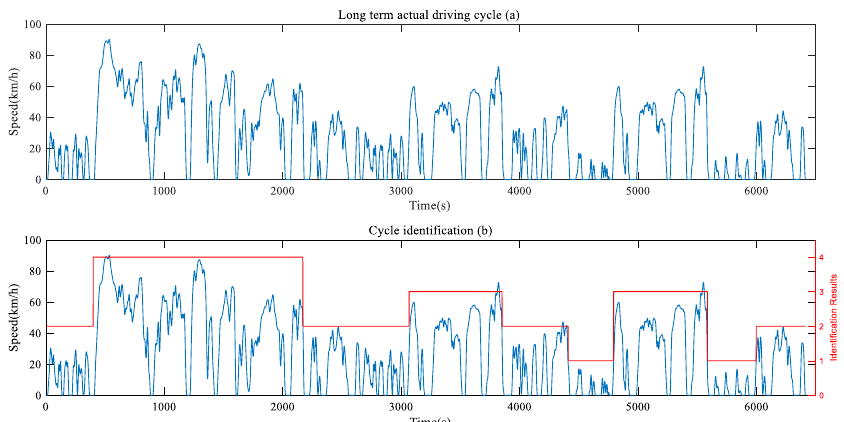
Figure 5. Long term actual driving cycle and cycle identification. ( a ) Long term actual driving cycle; ( b ) Cycle identification results.